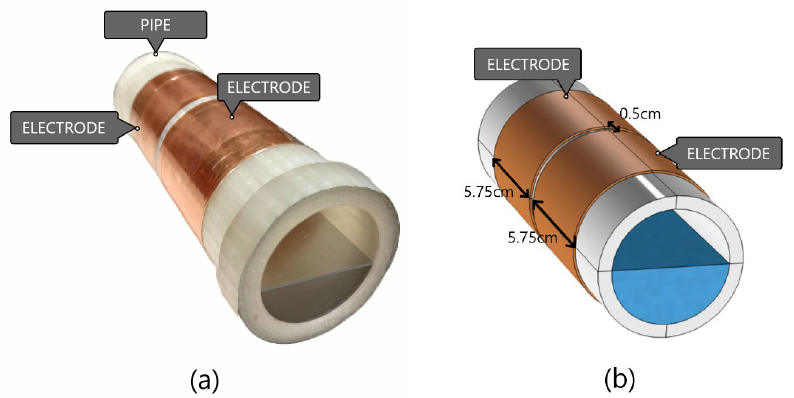
Figure 2. Double-ring sensor, ( a ) Experimental, ( b ) Simulation where the blue color represents the water level, the gray color represents the pipe, and the red color represents the electrodes.